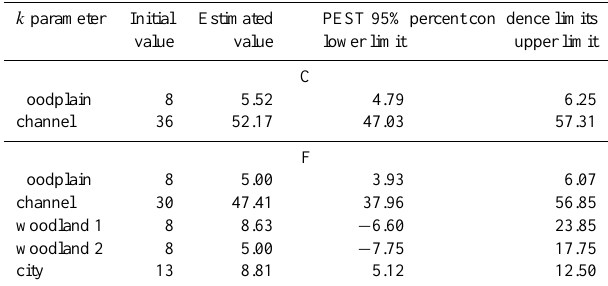
Table 6. Calibration results as given by PEST considering 343 data points.